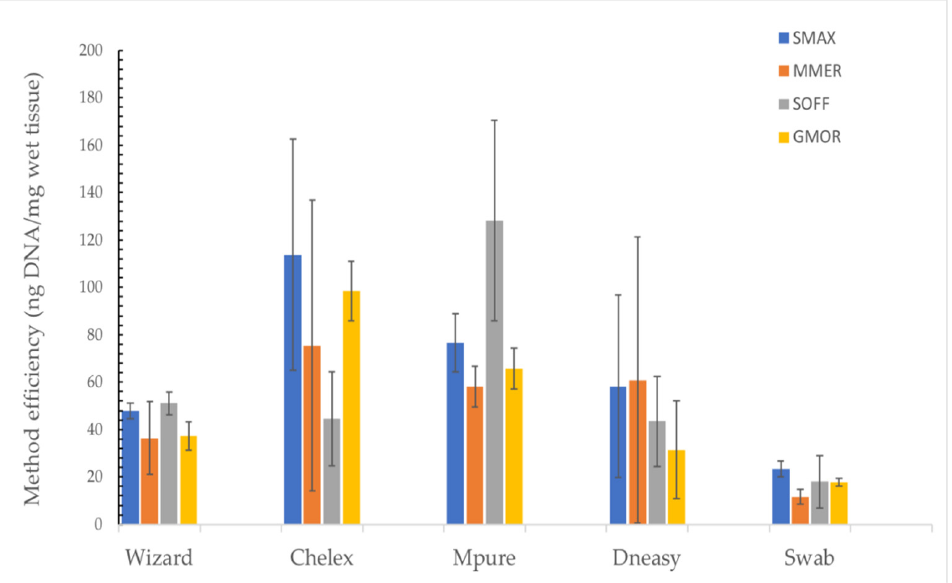
Figure 3. Method efficiency (ng DNA/mg wet tissue) of the tested methods per species. Data are presented as mean ± SD of individuals per species. Scophthalmus maximus (SMAX), Merluccius merluccius (MMER), Sepia officinalis (SOFF) and Gadus morhua (GMOR).